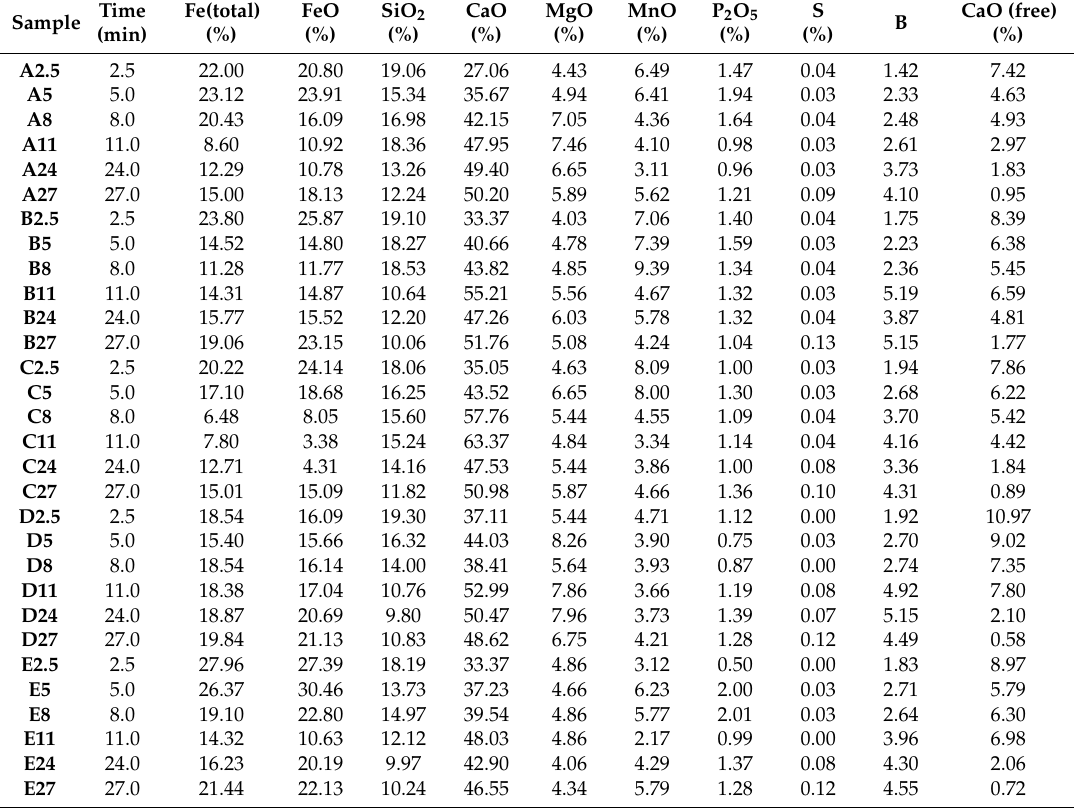
Table 2. Chemical analysis of slag samples.